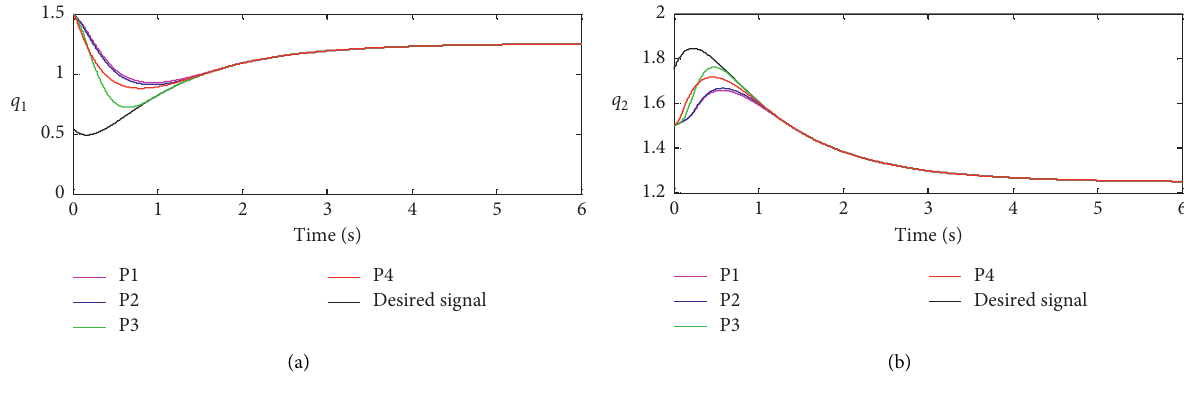
Figure 8: Position tracking performance with different parameters.